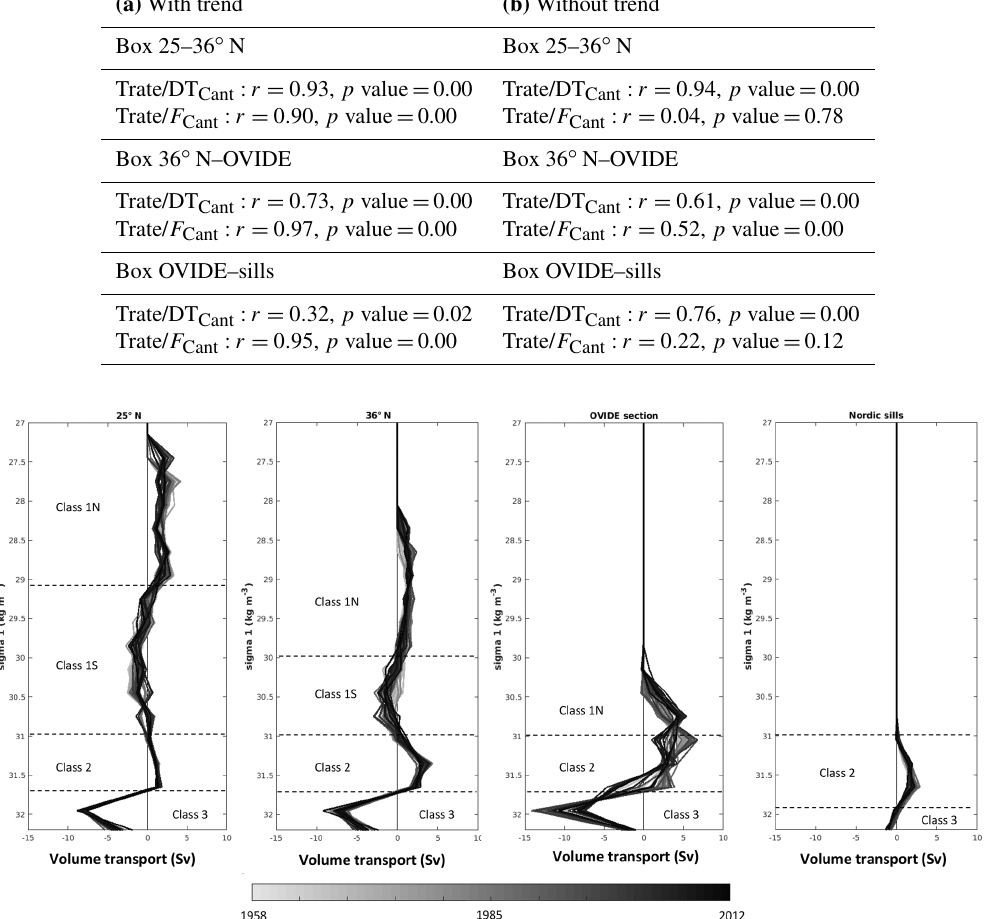
Figure 12. Distribution of volume transport integrated into density ( σ 1 ) layers with a 0.3kgm − 3 resolution for 25 ◦ N, 36 ◦ N, OVIDE and the Greenland–Iceland–Scotland sills over the period 1958–2012 (color bar). Dashed lines indicate the density limits of three water classes: Class 1N represents the northward flowing North Atlantic Central Water; Class 1S represents the southward flowing North Atlantic Central Water; Class 2 represents the Intermediate Water; Class 3 represents the North Atlantic Deep